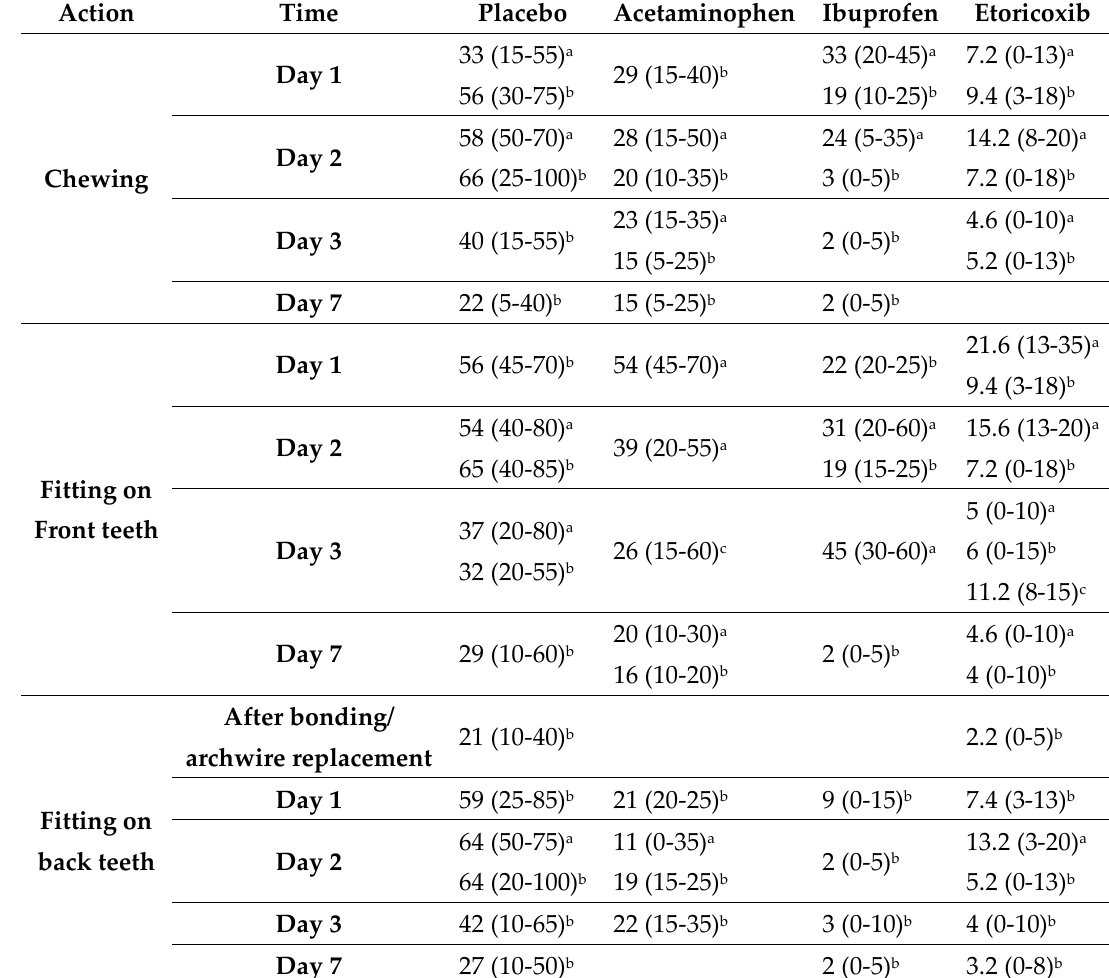
Table 2 Pain levels of the four groups at measured functions and time